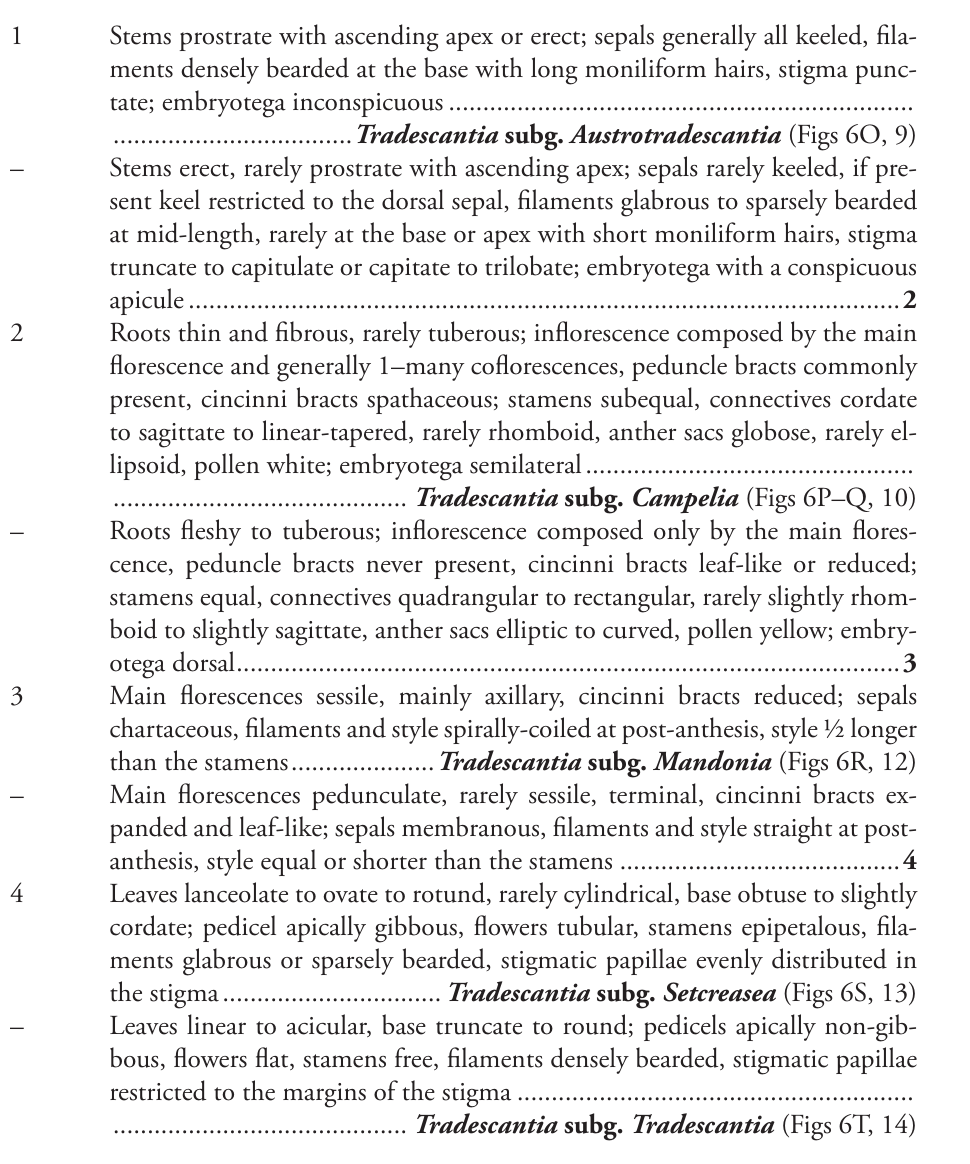
Roots fleshy to tuberous; inflorescence composed only by the main flores- cence, peduncle bracts never present, cincinni bracts leaf-like or reduced; stamens equal, connectives quadrangular to rectangular, rarely slightly rhom- boid to slightly sagittate, anther sacs elliptic to curved, pollen yellow; embry- Main florescences sessile, mainly axillary, cincinni bracts reduced; sepals chartaceous, filaments and style spirally-coiled at post-anthesis, style ½ longer Main florescences pedunculate, rarely sessile, terminal, cincinni bracts ex- panded and leaf-like; sepals membranous, filaments and style straight at post- Leaves lanceolate to ovate to rotund, rarely cylindrical, base obtuse to slightly cordate; pedicel apically gibbous, flowers tubular, stamens epipetalous, fila- ments glabrous or sparsely bearded, stigmatic papillae evenly distributed in Leaves linear to acicular, base truncate to round; pedicels apically non-gib- bous, flowers flat, stamens free, filaments densely bearded, stigmatic